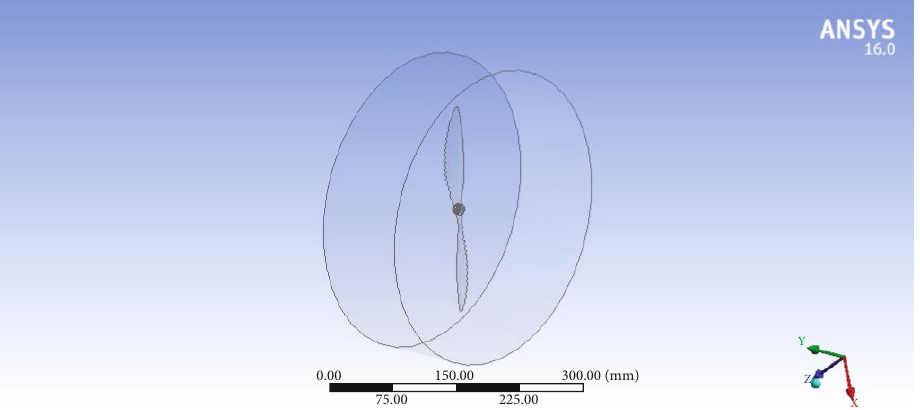
Figure 12: Rotation domain of Design-2.